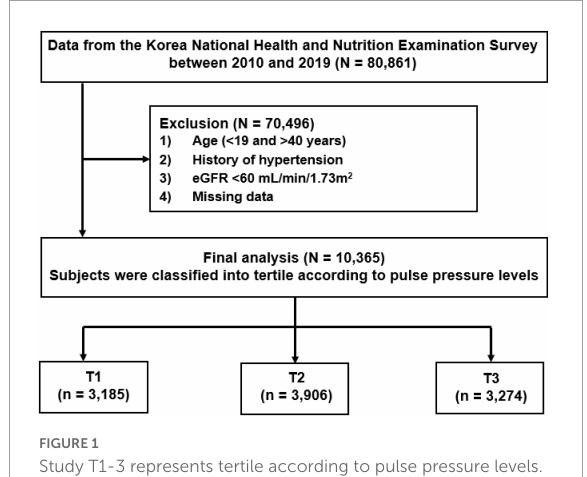
FIGURE1 Study T1-3 represents tertile according to pulse pressure levels. T1 is the lowest and T3 is the highest pulse pressure. eGFR, estimated glomerular filtration